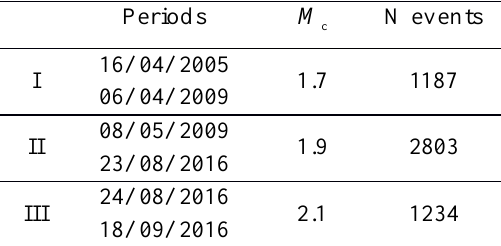
Table I: Time periods choose for the analysis. M and events in each period are also